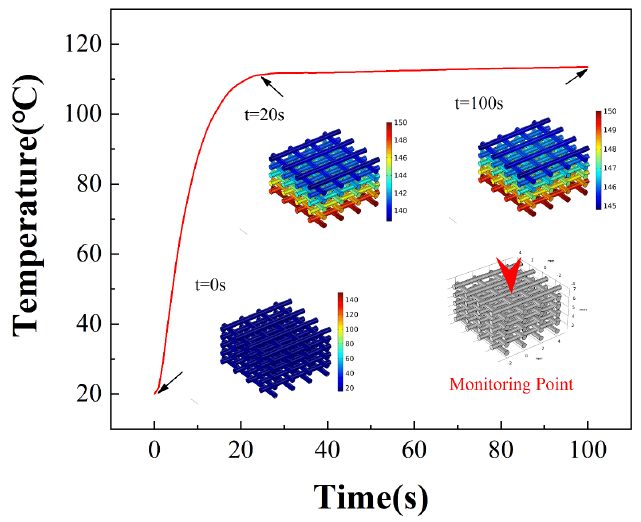
Figure 12. Temperature profile of silicone line in the top layer.